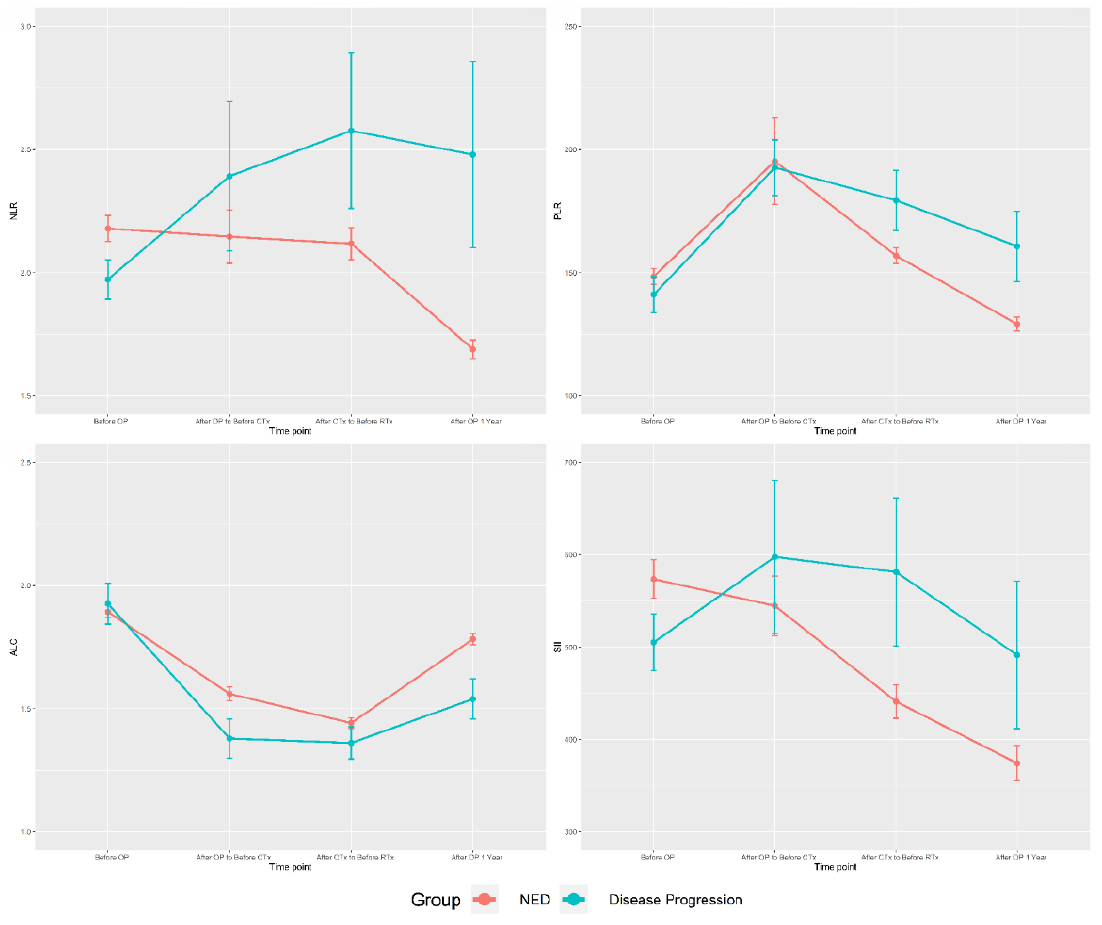
Figure 1. The inflammatory biomarkers according to disease progression. NLR: neutrophil-to-lymphocyte ratio; PLR: platelet-to-lymphocyte ratio; ALC: absolute lymphocyte count; SII: the systemic immune-inflammation index; CTx: chemotherapy; RTx: radiation therapy; NED: no evidence of disease.